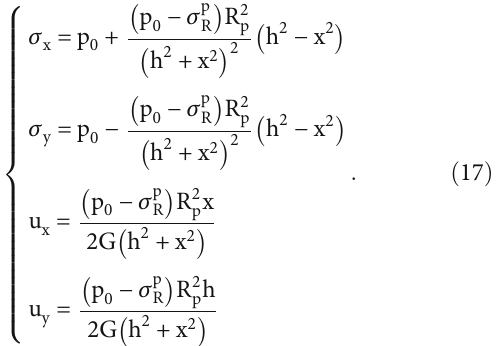
Figure 8: Strain distribution curve of surrounding rock in